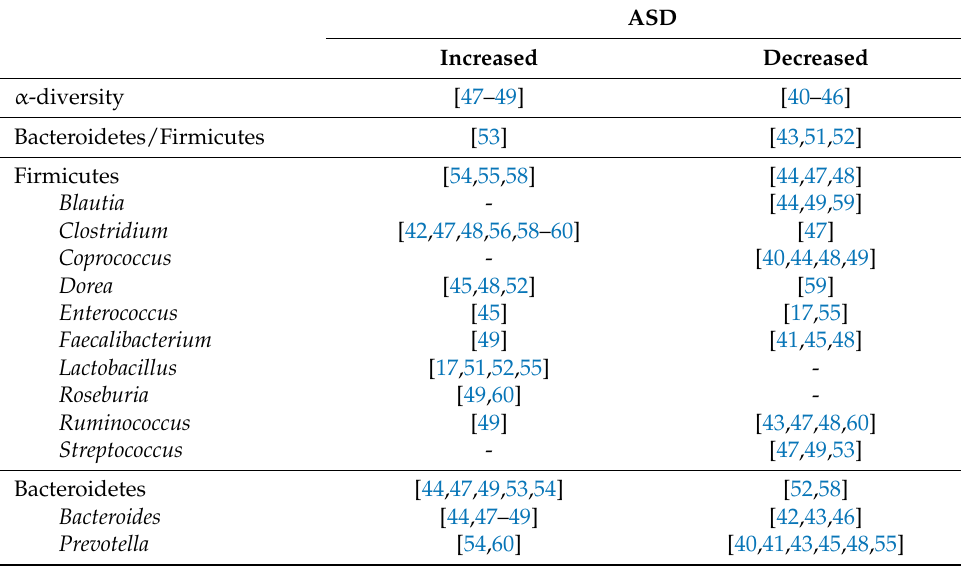
ASD Increased Decreased